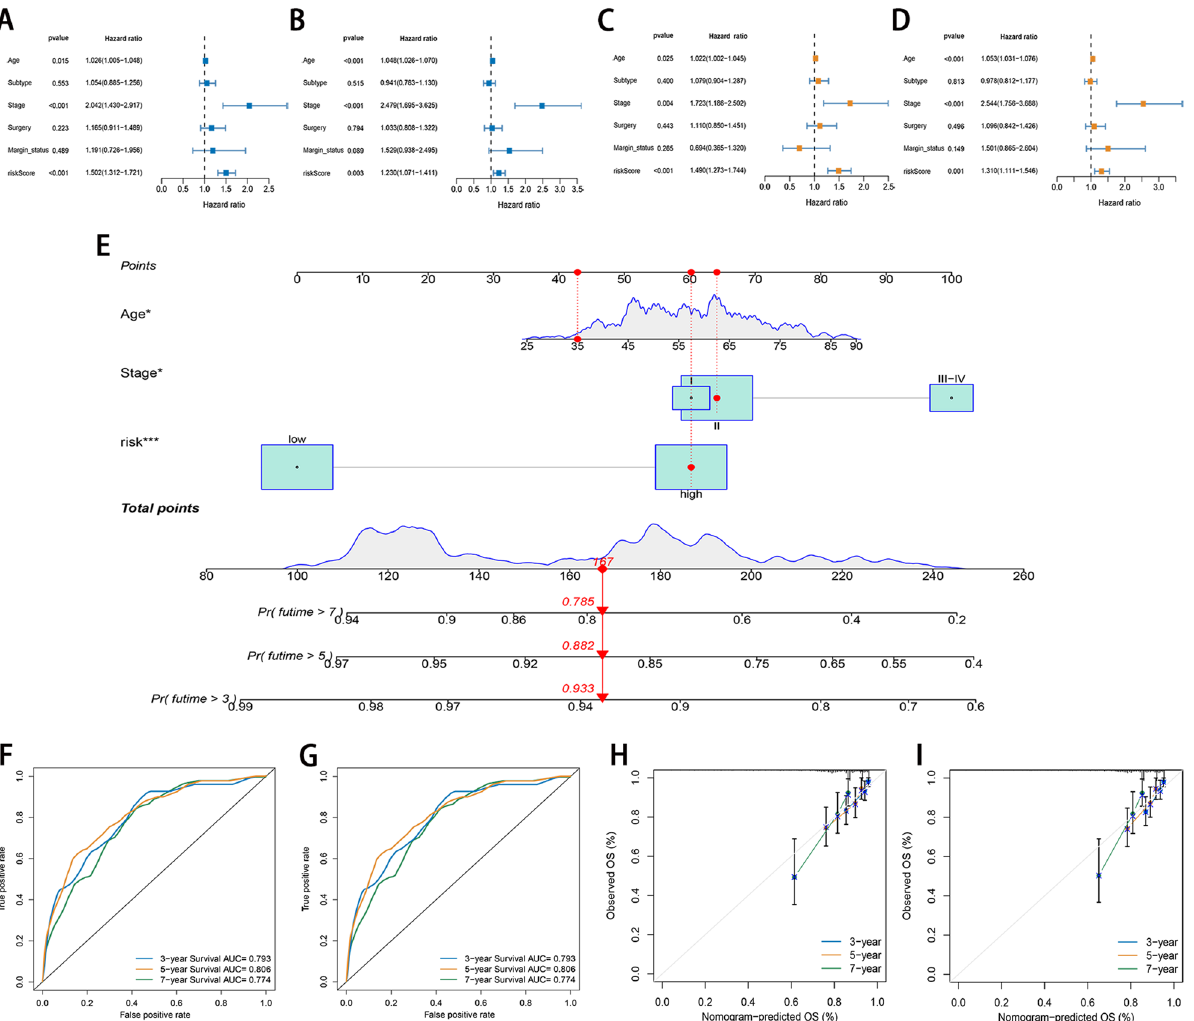
Figure 7. Construction and validation of the nomogram. ( A , B ) Univariate and Cox regression showed that the age, stage, and risk score were associated with OS in both sets. ( C , D ) Multivariate Cox regression shows that the age, stage, and risk score were independent prognostic indicators of OS in patients with breast cancer. ( E ) The nomogram combines risk signature and clinicopathological factors. ( F , G ) ROC curves for predicting the 3-, 5-, and 7-year ROC curves in the training and testing sets. ( H , I ) Calibration curves corrected for deviations in an agreement between the predicted and observed OS rates at 3, 5, and 7 years in both